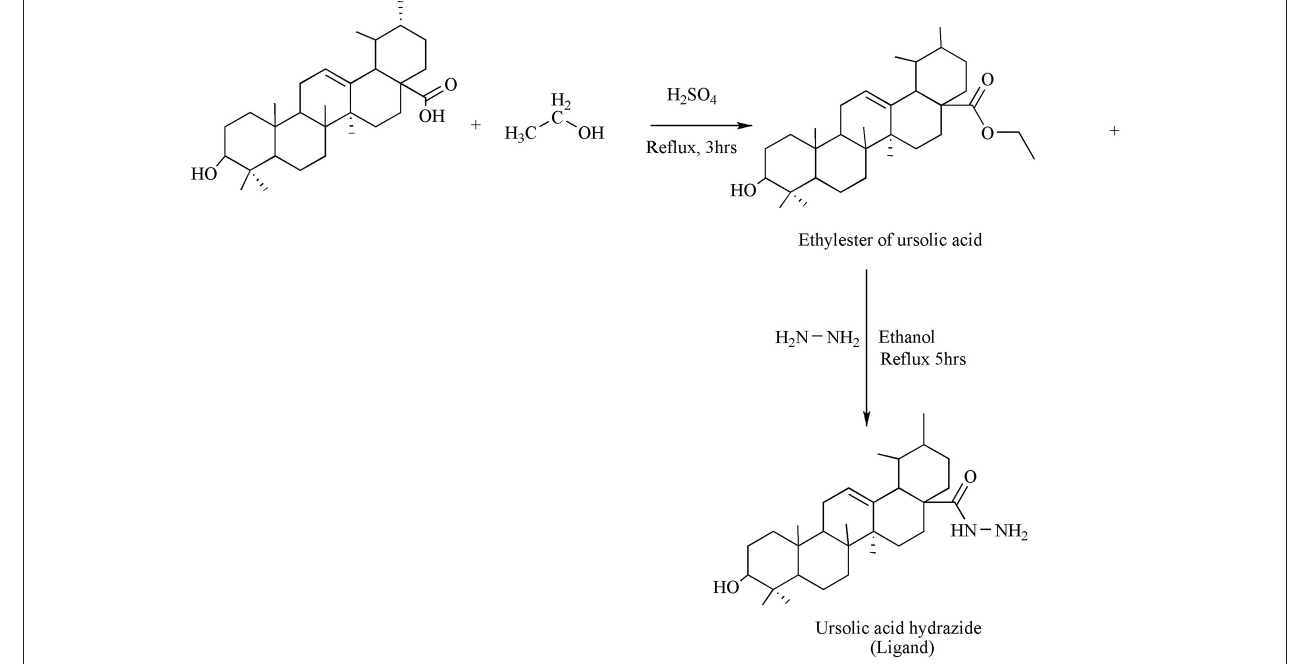
FIGURE 1 | Synthesis of Ligand.